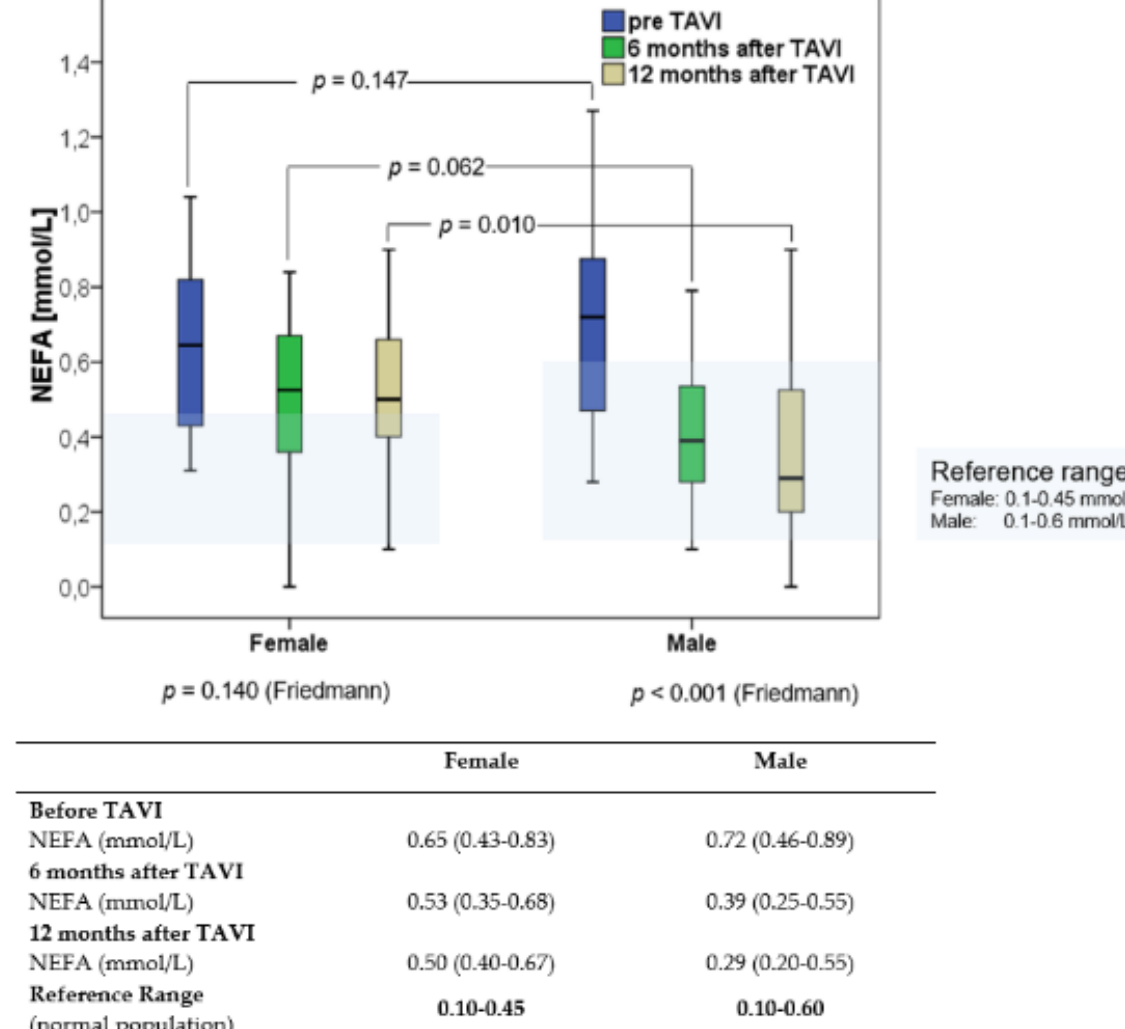
Figure 2. Sex-specific changes in non-esterified fatty acids (NEFA) over 12 months after Transcatheter Aortic Valve Implantation.